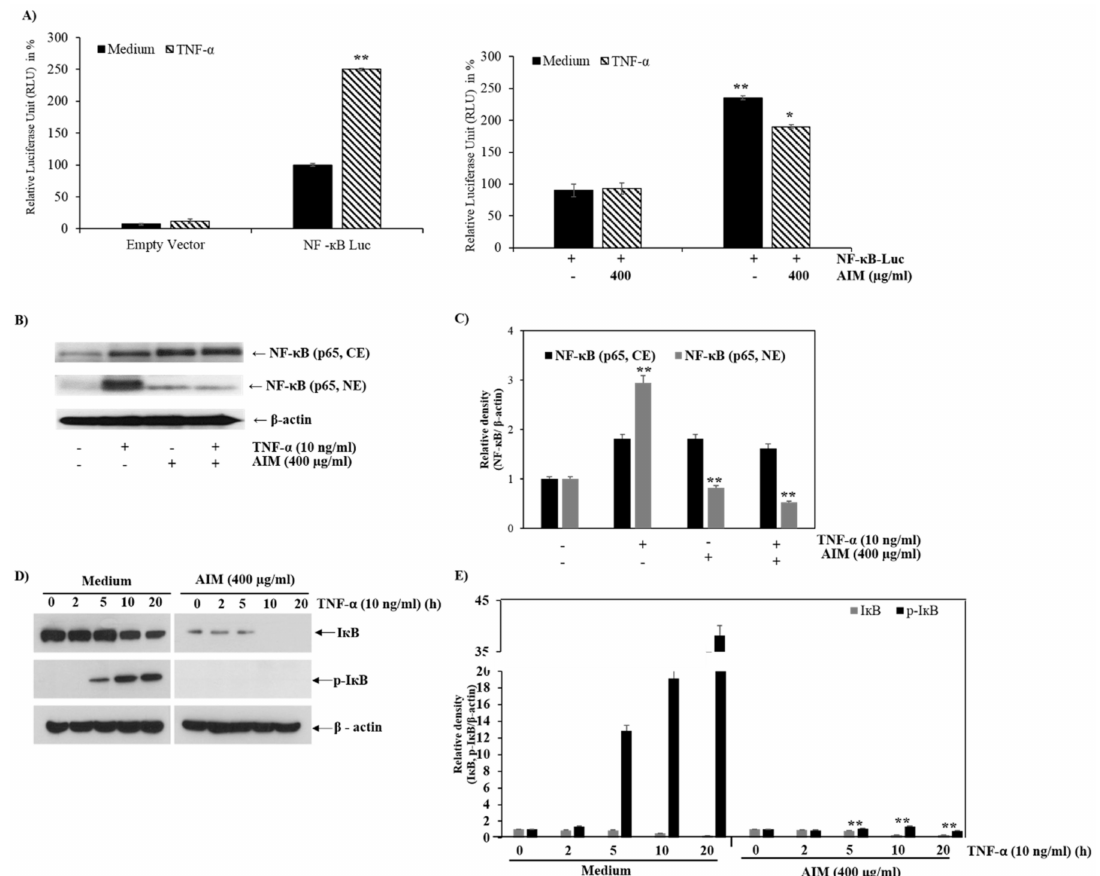
Figure 5. E ff ects of AIM on NF- κ B and the I κ B α phosphorylation. ( A , Left) 1 µ g of the NF- κ B-luciferase empty vector were transfected into MCF-7 cells; (right) 24 h after transfection, the cells were treated with 10 ng / mL of TNF- α , with or without 1 h pre-treatment of AIM (400 µ g / mL). The luciferase activity was represented in fold change and compared against the untreated group. ( B ) Repressive e ff ects of AIM on TNF- α -induced NF- κ B translocation from the cytoplasm to nucleus. The cells treated with 10 ng / mL of TNF- α pretreated with or without 400 µ g / mL of AIM for 1 h were taken for western blot analysis. Nuclear (NE) and cytoplasmic extracts (CE) isolated from the total lysates were resolved in SDS-polyacrylamide gels. ( C ) Densitometry analysis of the data in western blot analysis by ImageJ software. The values were normalized against β -actin. ( D ) Inhibitory e ff ects of AIM on TNF- α induced I κ B α phosphorylation. A total of 30 µ g of protein lysates from the indicated treatment cells were used for western blot analysis. ( E ) Densitometry analysis of the data in western blot analysis by ImageJ software. The values were normalized against β -actin. ** p < 0.01 vs. the control